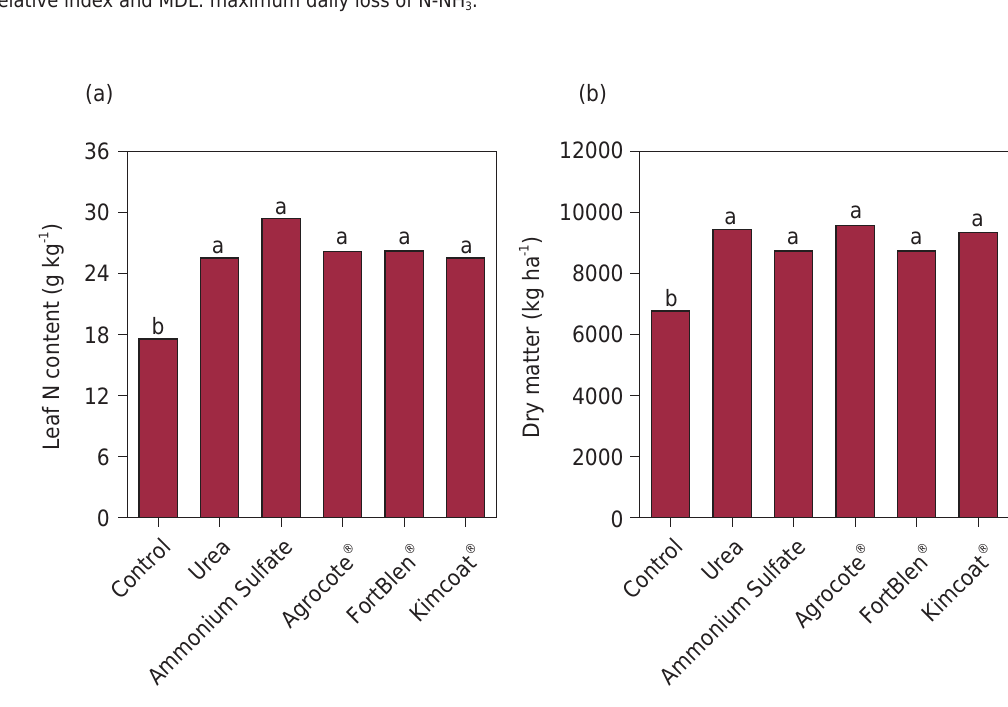
Figure 4. Leaf nitrogen content (a) and dry matter of corn (b), after broadcast fertilization with 60 kg ha -1 using urea, ammonium sulfate, and